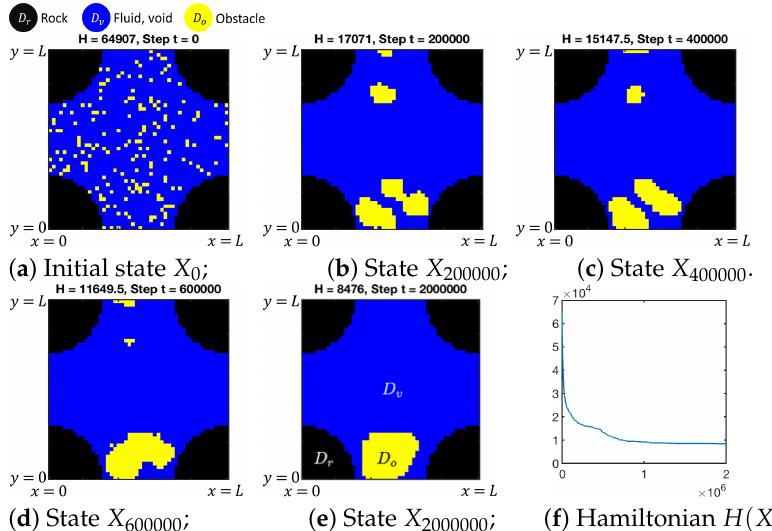
Figure 11. States of the LP process for the formation of an obstruction with weights given in Table 4. Rock matrix D r is black and void space D v is blue, while the obstructions in D o are yellow. M = 50 ×